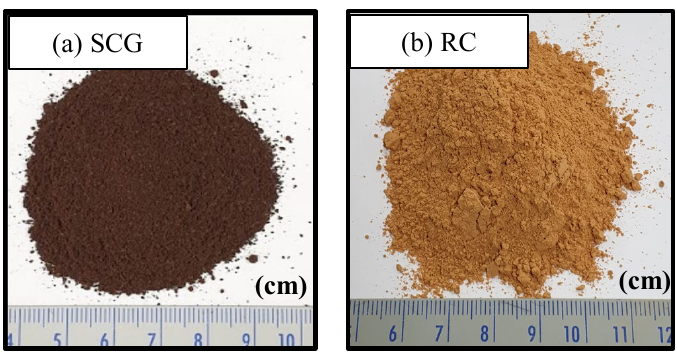
Figure 1. Particle size distribution of the sieved SCG and RC.